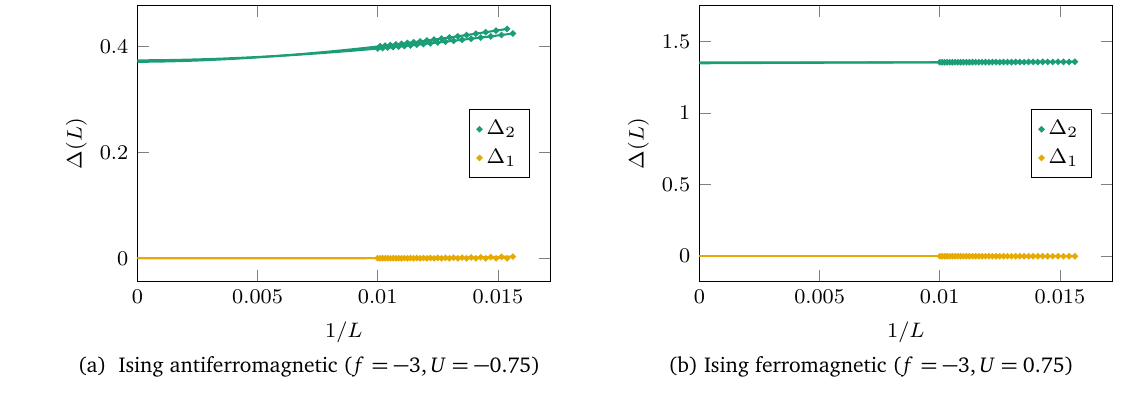
for representative points in the n = 0, show- 1 > 0 in the thermody- 2